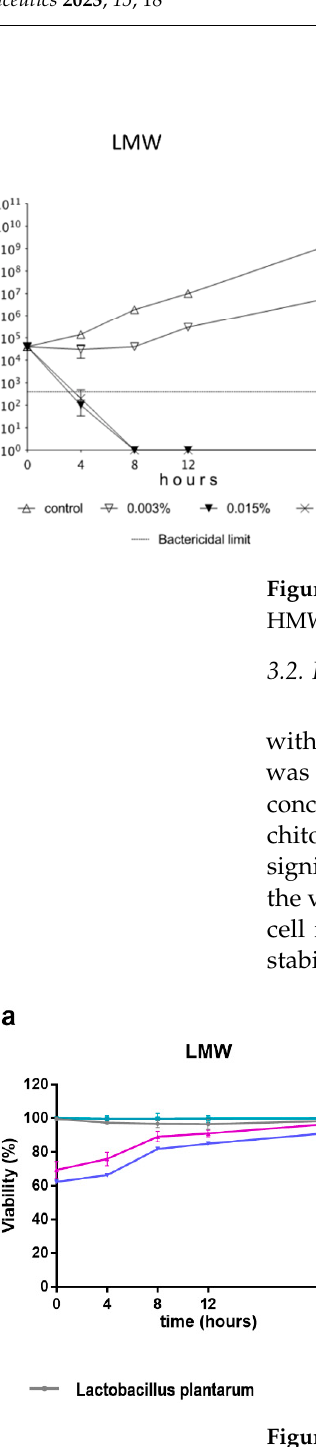
Figure 2. Viability of L. plantarum after treatment with different concentration of low molecular weight (LMW) chitosan ( a ), medium molecular weight (MMW) chitosan ( b ), and high molecular weight (HMW) chitosan ( c ). The investigation was done in triplicates.